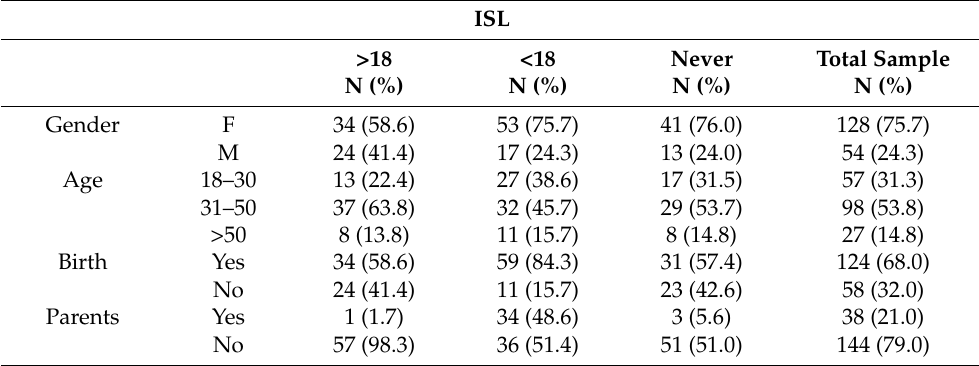
Table 1. Distribution of gender, age, birth deaf condition and deaf parents in the groups.